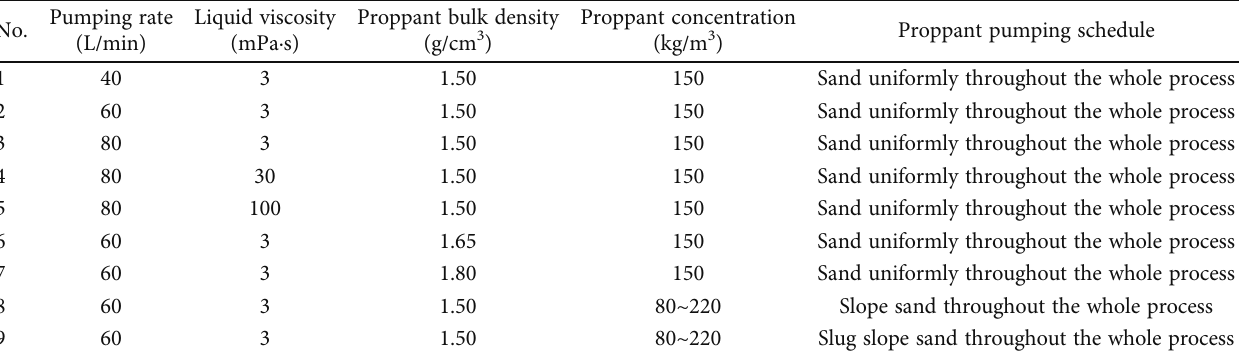
Table 4: Experimental scheme of proppant settlement and transport in proppant-supported fracture of volumetric fracturing proppant. Pumping rate No. (L/min)